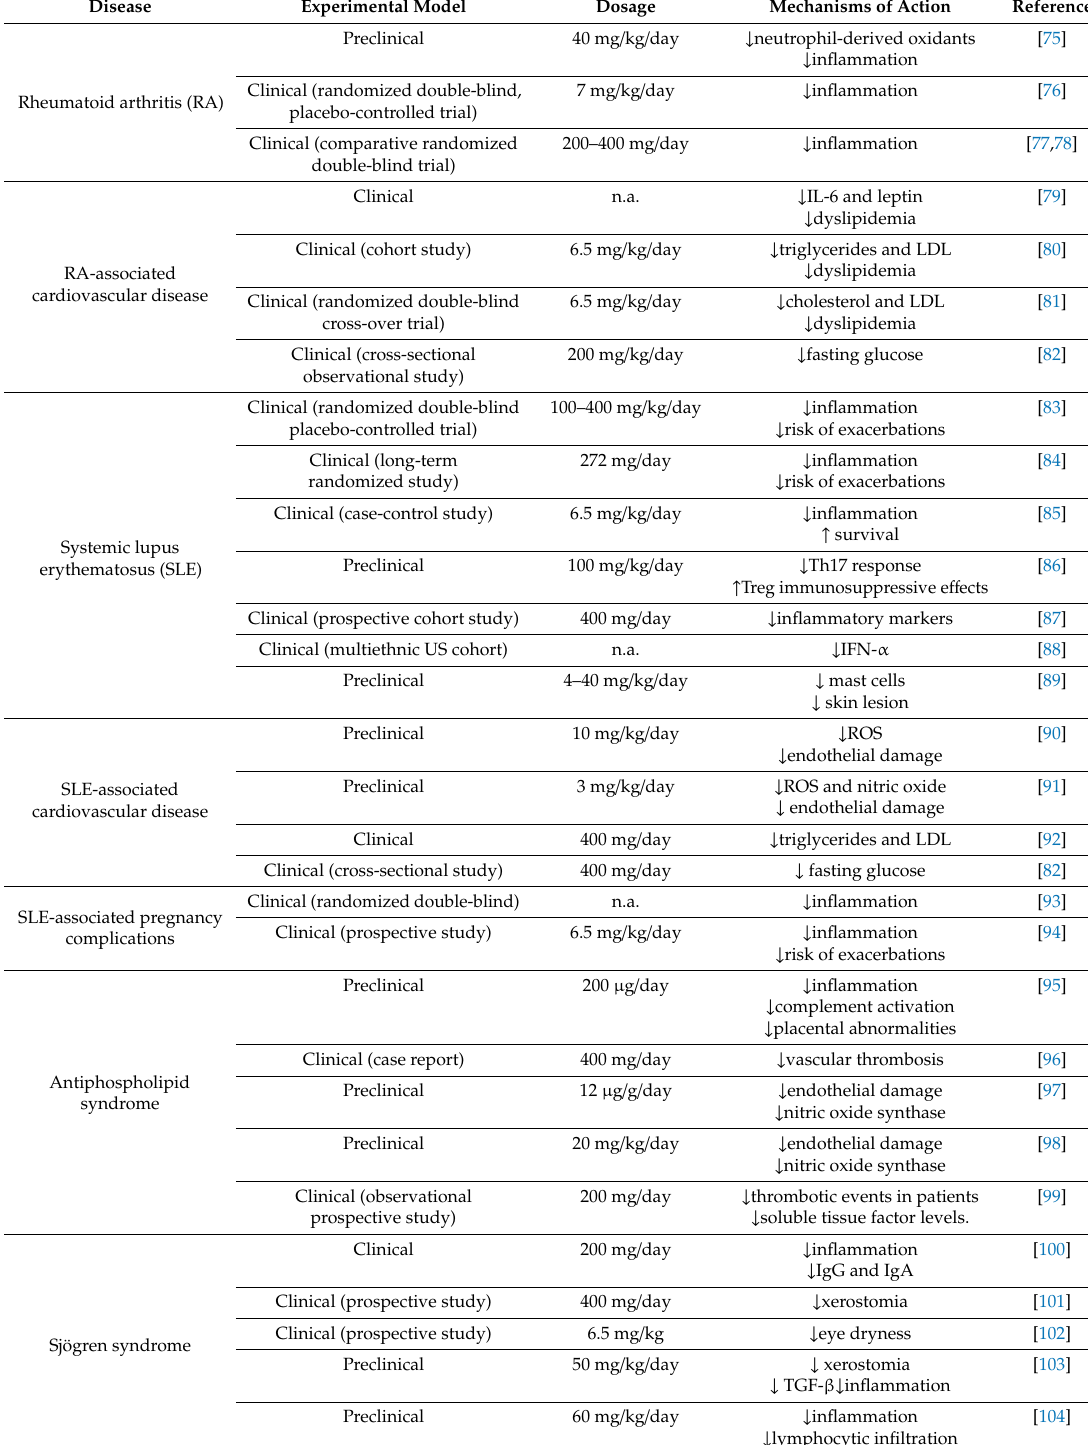
Table 2. Main mechanisms of action underlying biological e ff ects of